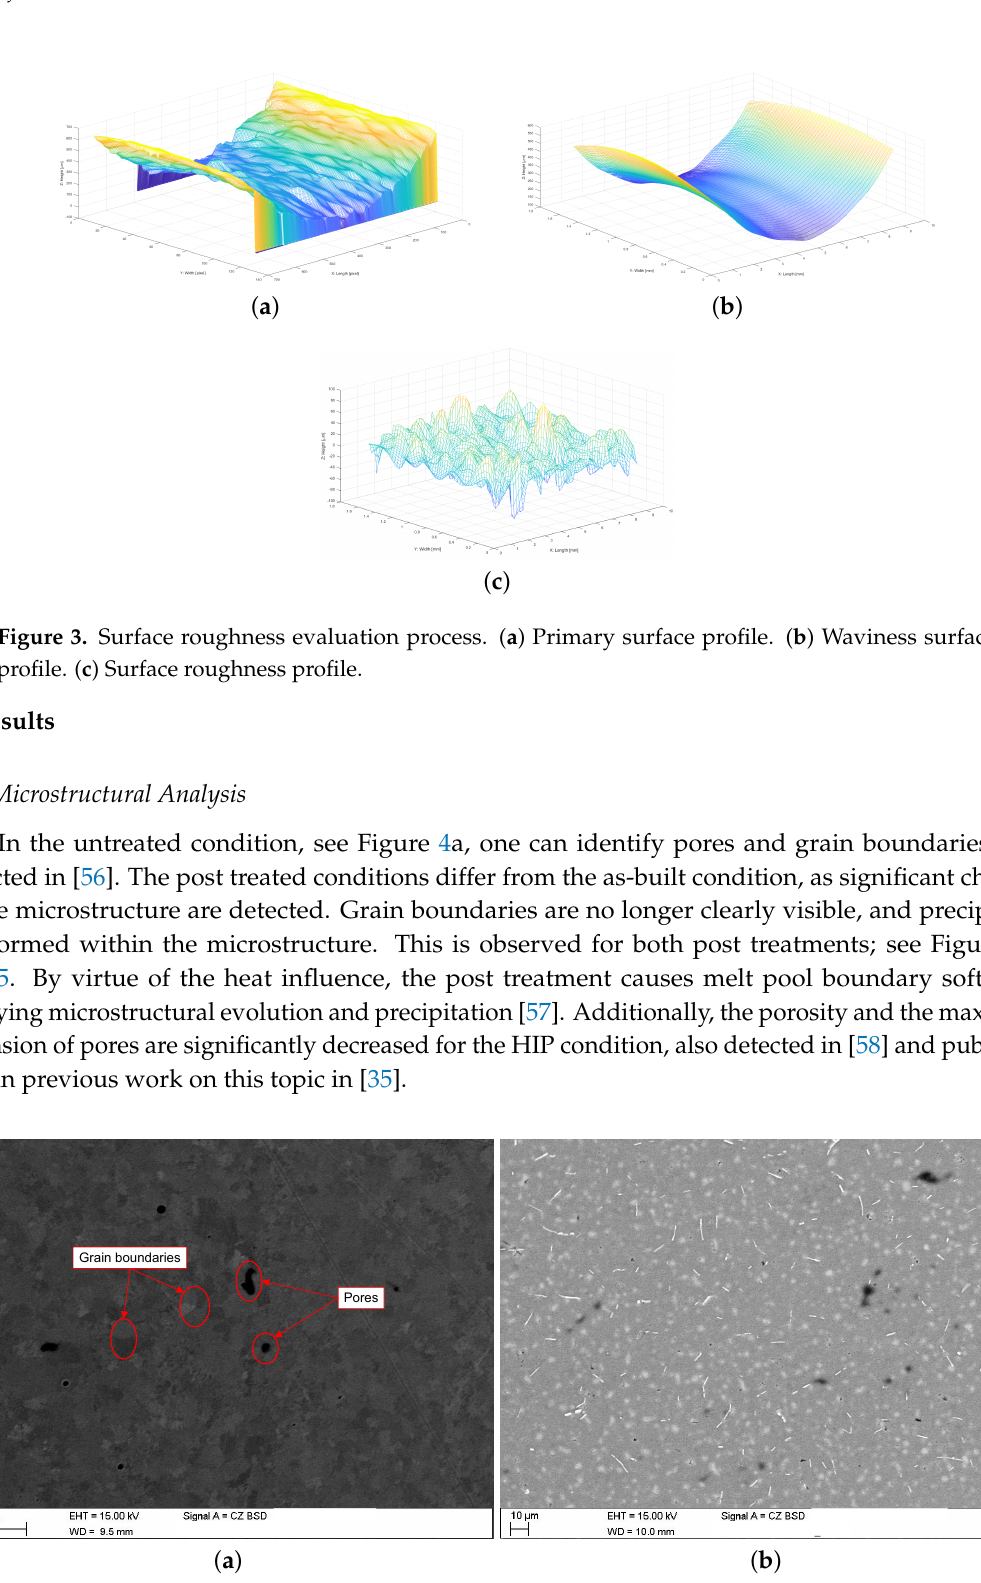
Figure 4. Microstructural analysis. ( a ) Microstructure of the AB condition [35]. ( b ) Microstructure of the SA